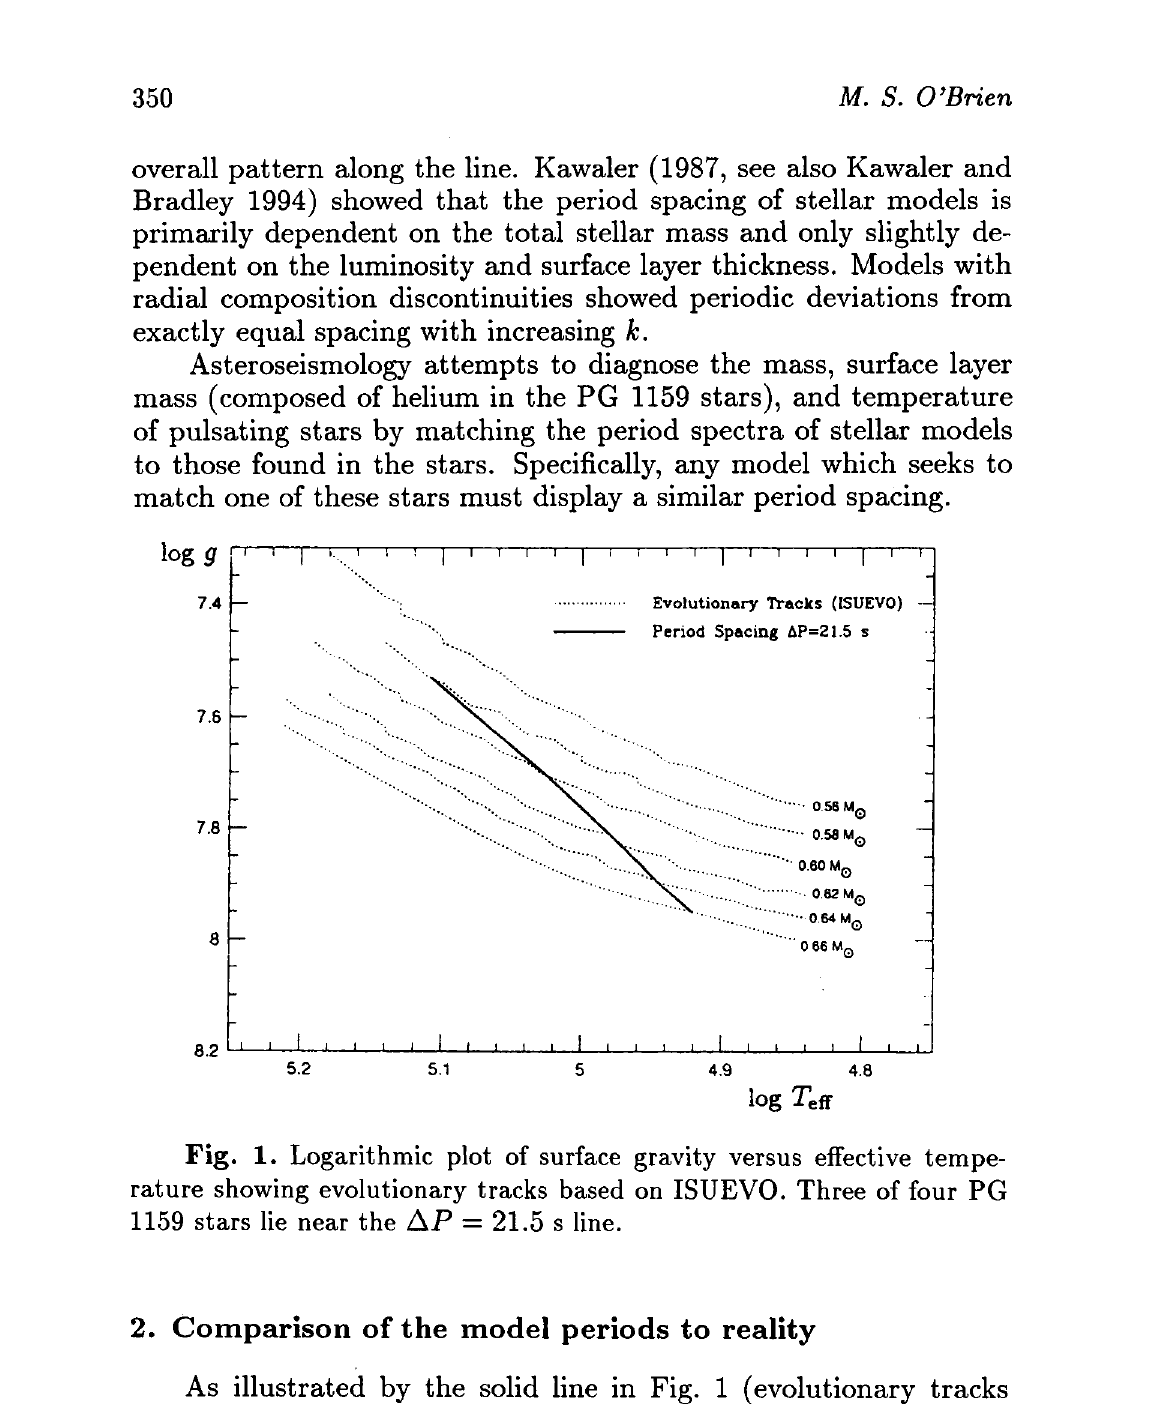
Fig. 1. Logarithmic plot of surface gravity versus effective tempe- rature showing evolutionary tracks based on ISUEVO. Three of four PG 1159 stars lie near the AP = 21.5 s